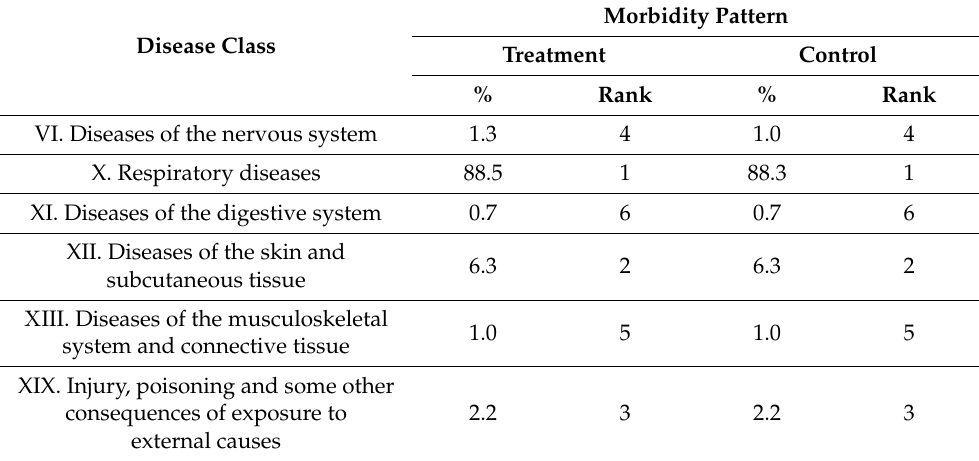
Table 10. Morbidity patterns in the control group by the most prevalent classes of diseases, %,